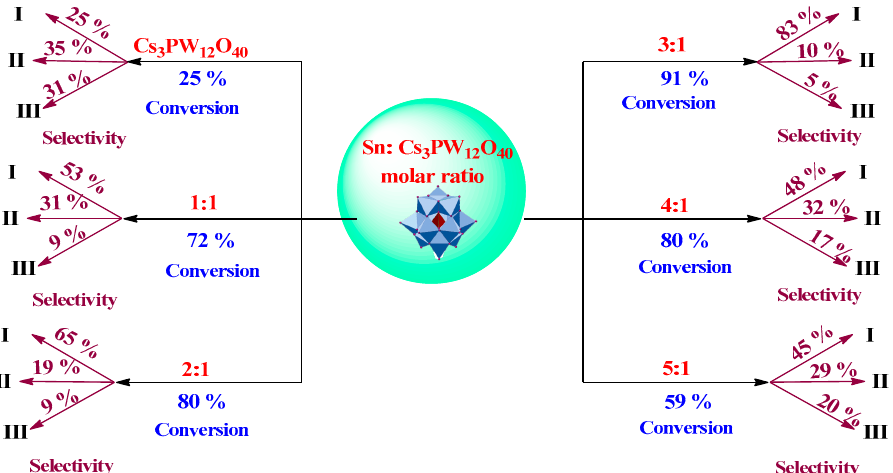
Figure 33. Impact of mora ratio of Sn to Cs 3 PW 12 O 40 on the conversion and selectivity of glycerol carbonation with urea (adapted from ref. [75]).